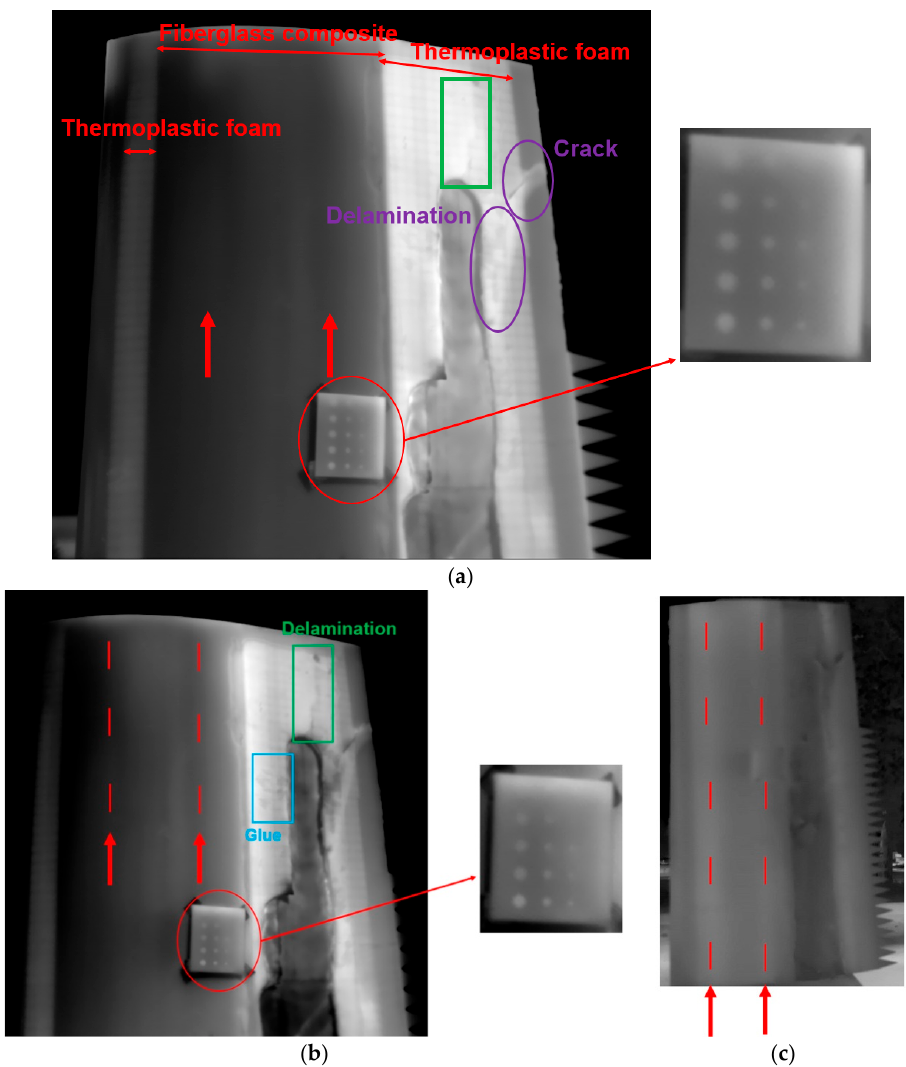
Figure 13. ( a ) Thermographic results of the experiment around 9 a.m., ( b ) noon and ( c ) 6 p.m. (sunrise and sunset were around 5.53 a.m. and 9.30 p.m., respectively). The vertical arrows and dashed lines indicate the shear webs.